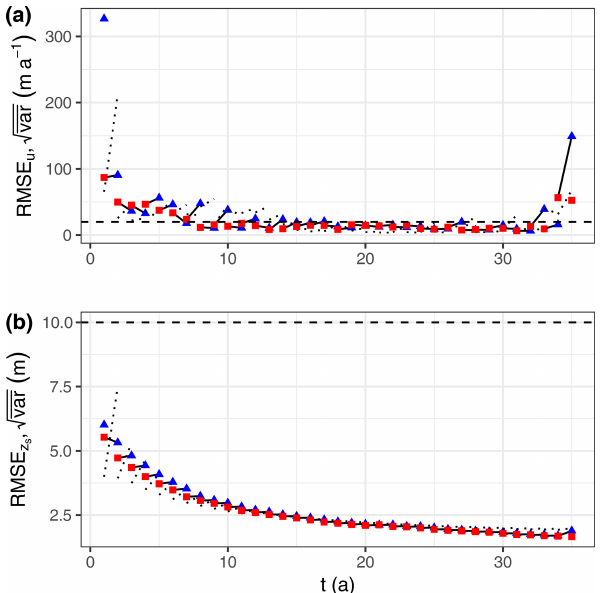
Figure 9. RMSE (solid lines) and square root of the averaged en- semble variance (dashed lines) during the assimilation window for (a) the velocity, u , and (b) the free surface, z s . Each year, the blue triangle and the red square are the RMSEs before and after the anal- ysis, respectively. Each segment represents a 1-year forecast